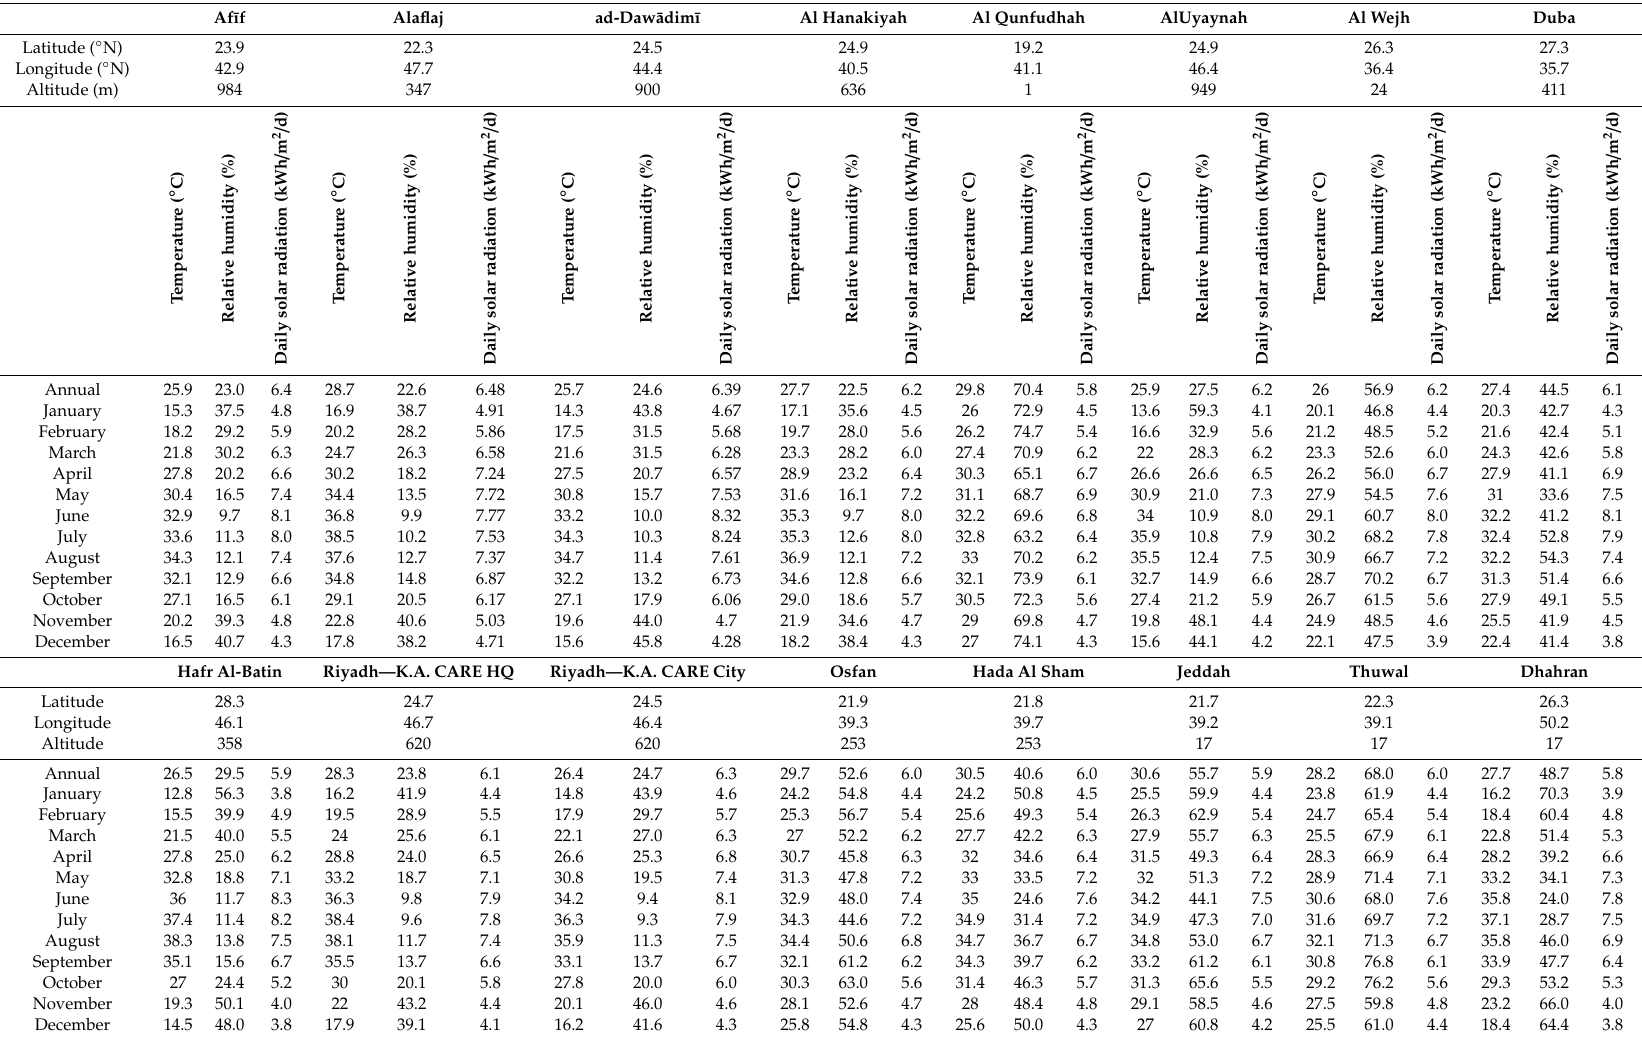
Table 3. Location and climatic data for all sites under